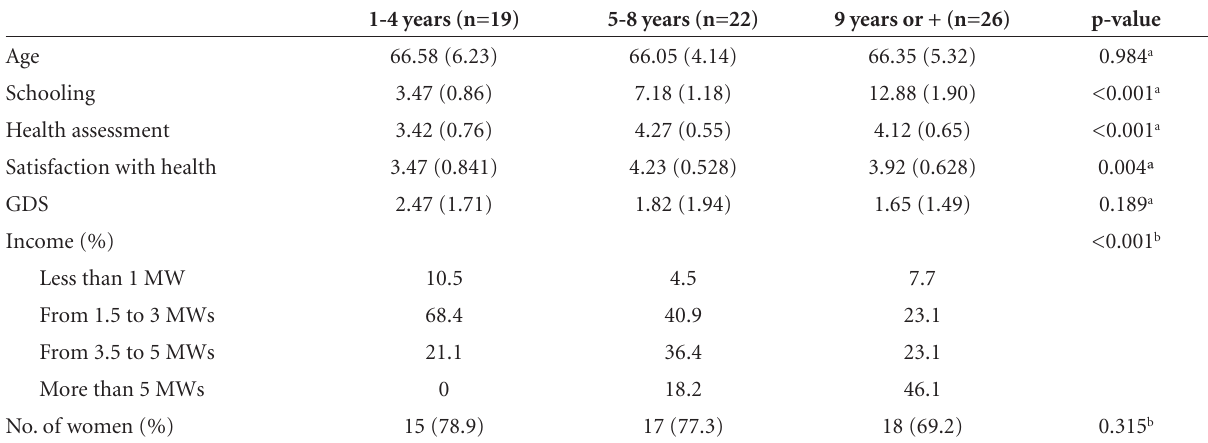
Table 1. Characterization of sample by schooling level, mean and standard deviation (in